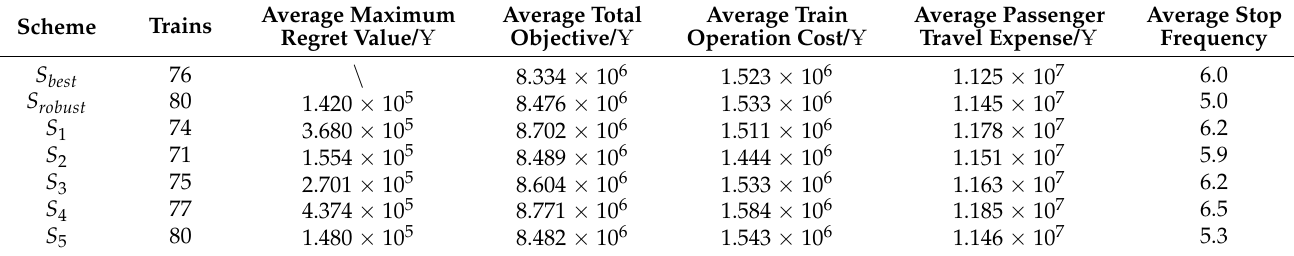
Table 5. Comparison of indicators under the three implementation scenarios.